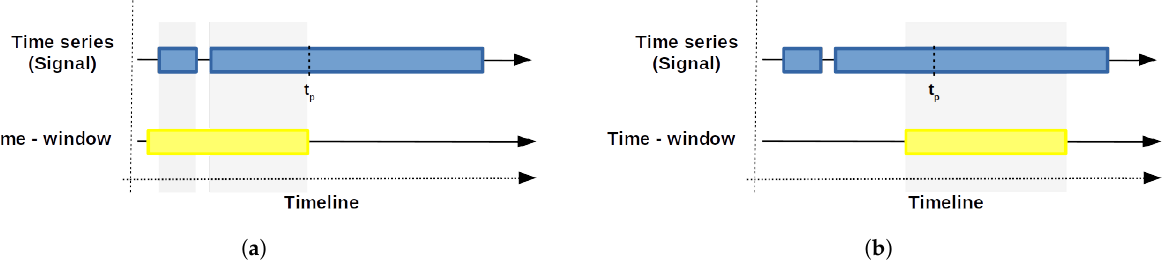
Figure 3. Time-window examples. ( a ) Time-window with missing values. ( b ) Time-window without missing